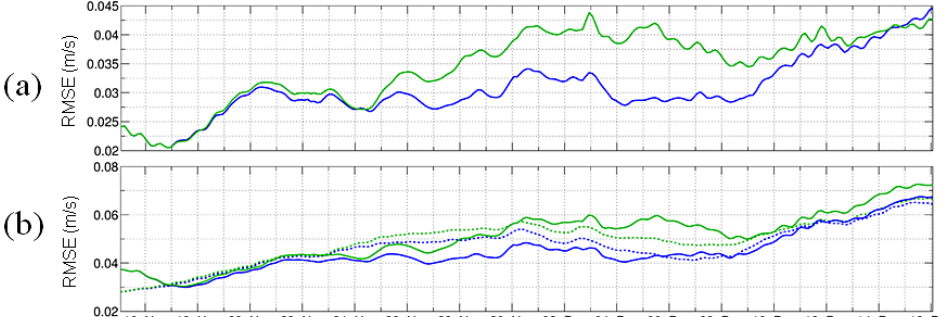
Figure 12. Time evolution of (a) Er a , b (y) and (b) Er a , b ( U ) computed over the POD (full lines) or the MD (dashed lines) for ObcTE . Er b (Er a ) is in green (blue).